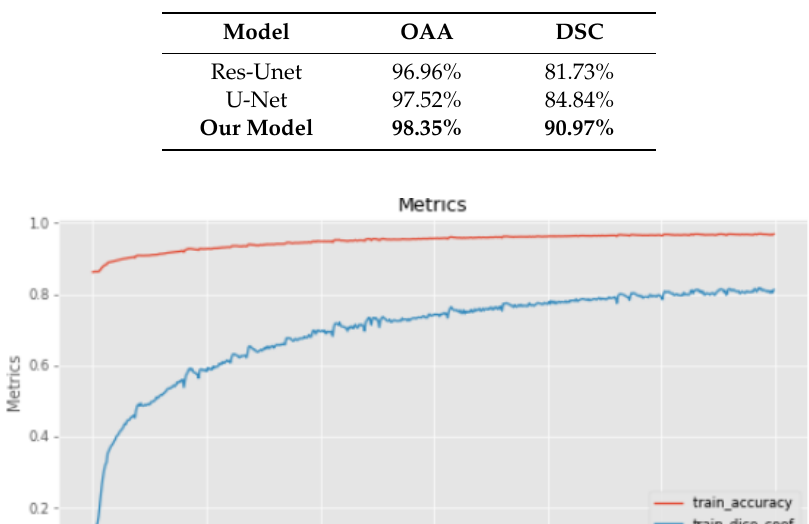
Table 3. The comparison results.